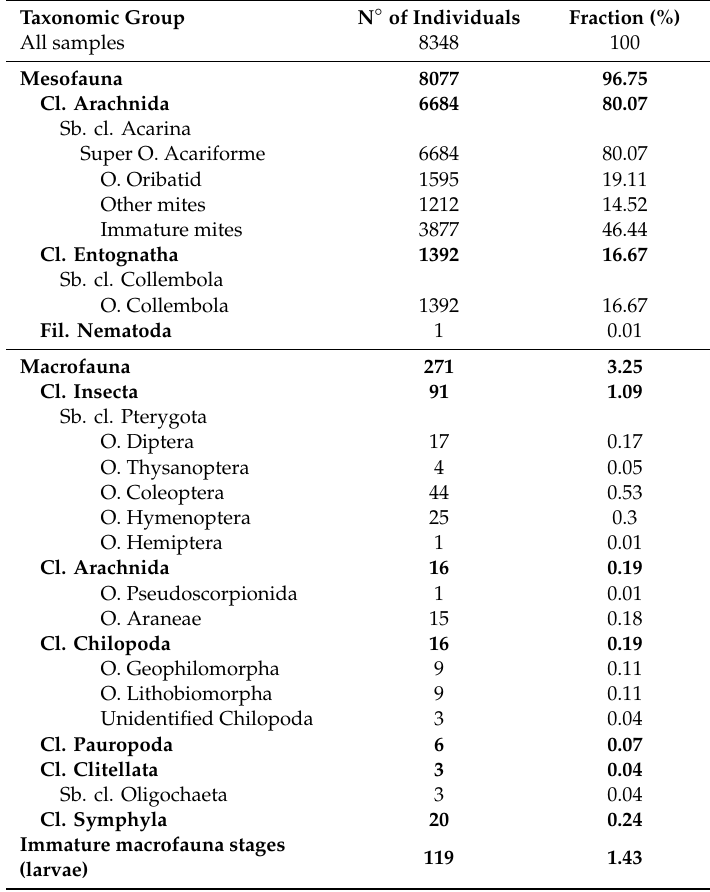
Table 3. Total number of individuals of the taxonomic groups identified in decomposing woody debris, the taxa are classified by size (mesofauna and macrofauna). Cl.: class, Sb. Cl.: sub-class; O.: order; Fil.: Filum. Bold case indicates the highest taxonomic orders (meso- and macrofauna, Class or